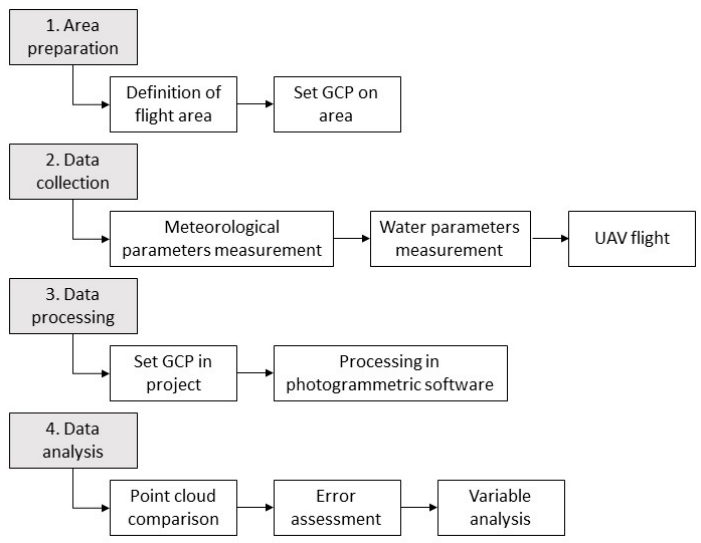
Figure 1. Methodology flow chart.